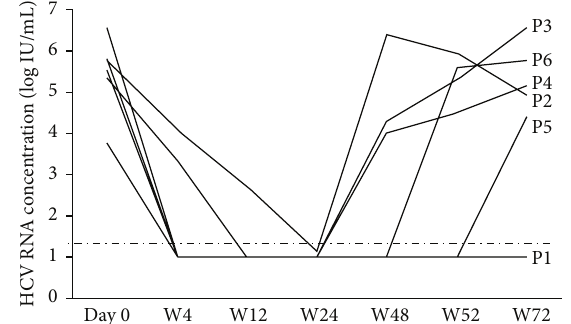
Figure 1: Evolution of hepatitis C virus RNA concentration during and after